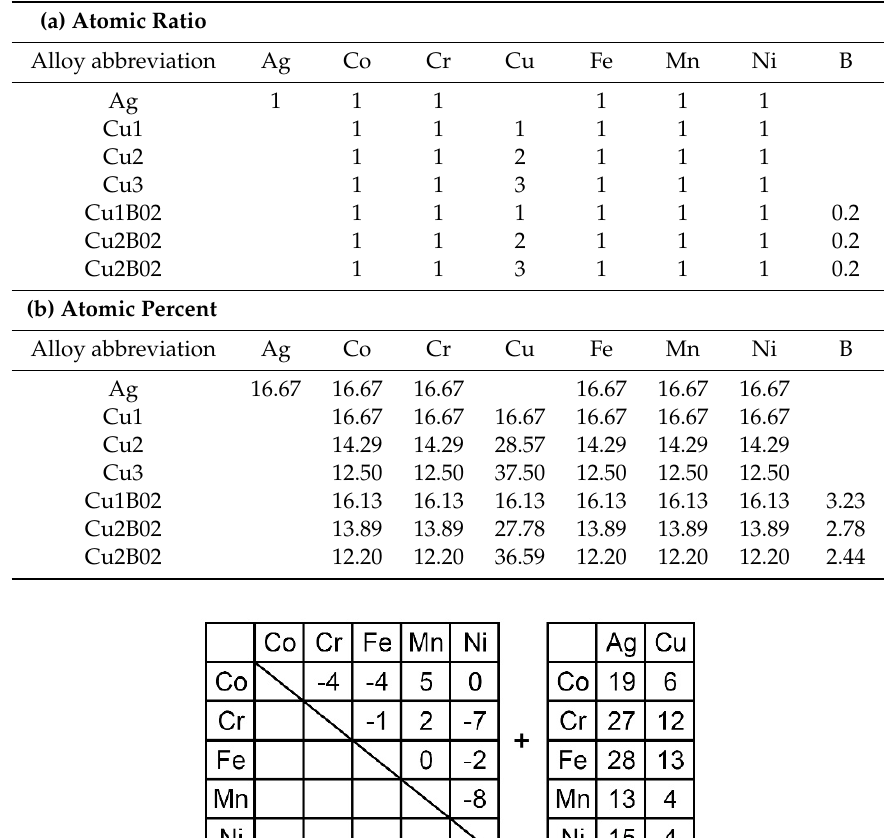
Table 1. Composition and alloy abbreviation investigated in the present study. (a) Atomic ratio, (b) atomic percent (at %).